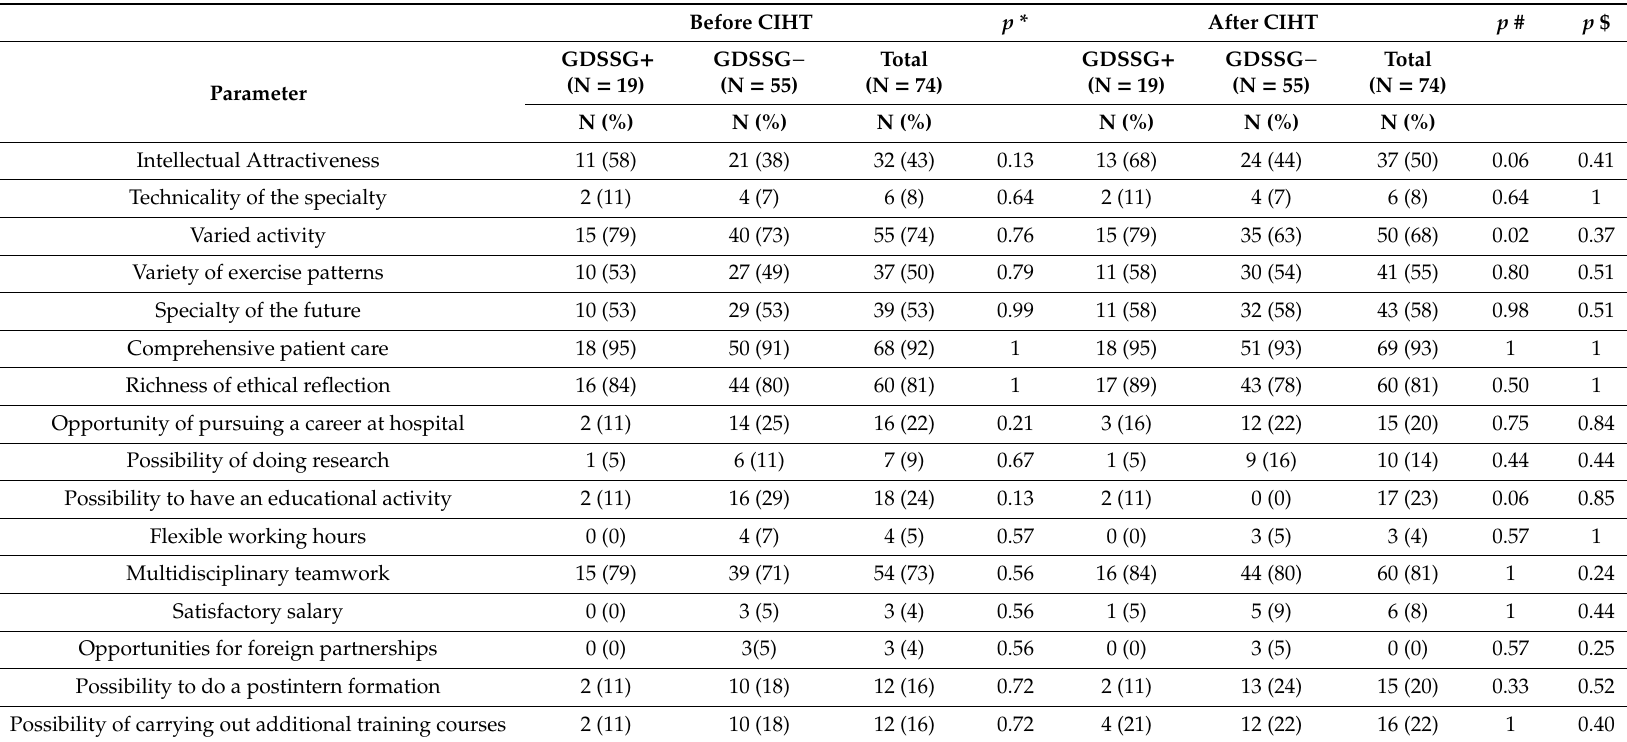
Table 3. Strengths of geriatrics according to students before and after CIHT for the GDSSG + or GDSSG −